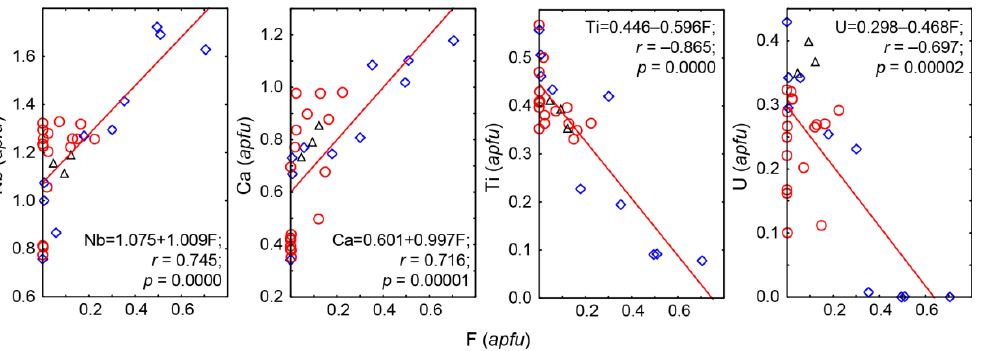
Figure 5. Nb, Ti, Ca and U content vs. fluorine amount in PSM.